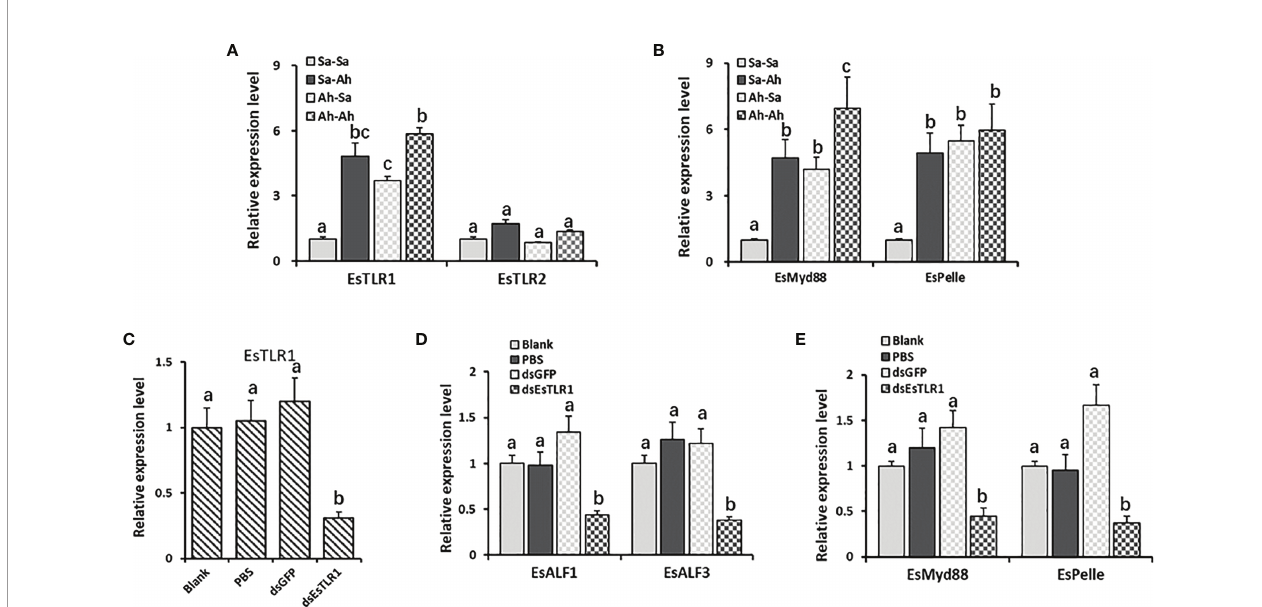
FIGURE 7 | The key roles of TLR1 signal in regulating the expressions of ALFs. (A) The expression levels of Es TLR1 and Es TLR2 after A. hydrophila priming and challenging stimulation; (B) The expression levels of TLR signal component Es Myd88 and Es Pelle after A. hydrophila priming and challenging stimulation; (C) The expression levels of Es TLR1 after RNAi by ds Es TLR1 injection; (D) The expression levels of Es ALF-1 and Es ALF-3 after Es TLR1 inhibition; (E) The expression levels of TLR signal component Es Myd88 and Es Pelle after Es TLR1 inhibition. Vertical bars represent the mean ± S. D. (N = 3), the letters (a, b, c) were used to present signi fi cant differences (p <